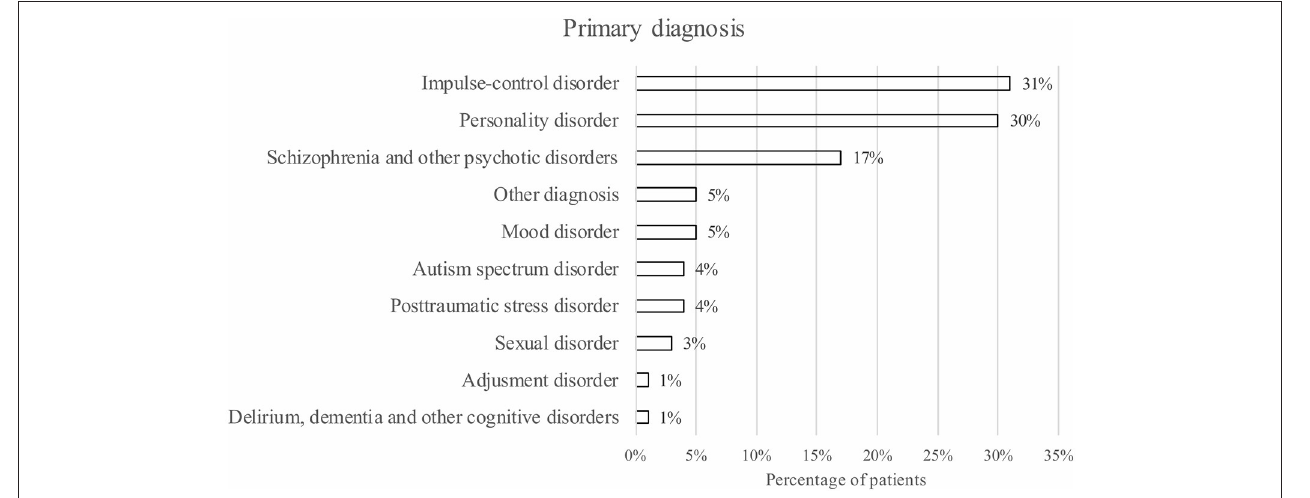
FIGURE 1 | The primary diagnoses of the ForFACT patients ( n =